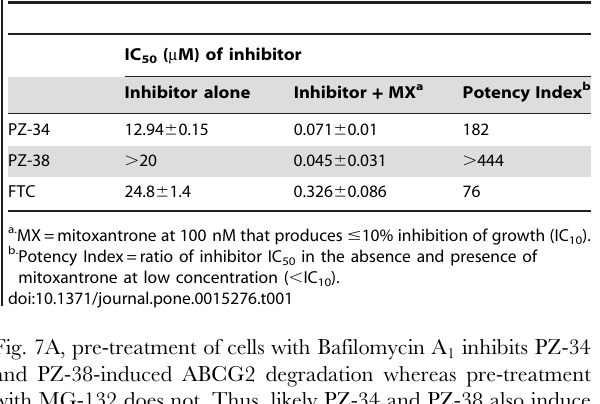
Fig. 7A, pre-treatment of cells with Bafilomycin A 1 inhibits PZ-34 and PZ-38-induced ABCG2 degradation whereas pre-treatment with MG-132 does not. Thus, likely PZ-34 and PZ-38 also induce ABCG2 degradation in lysosome, same as PZ-39 [7].